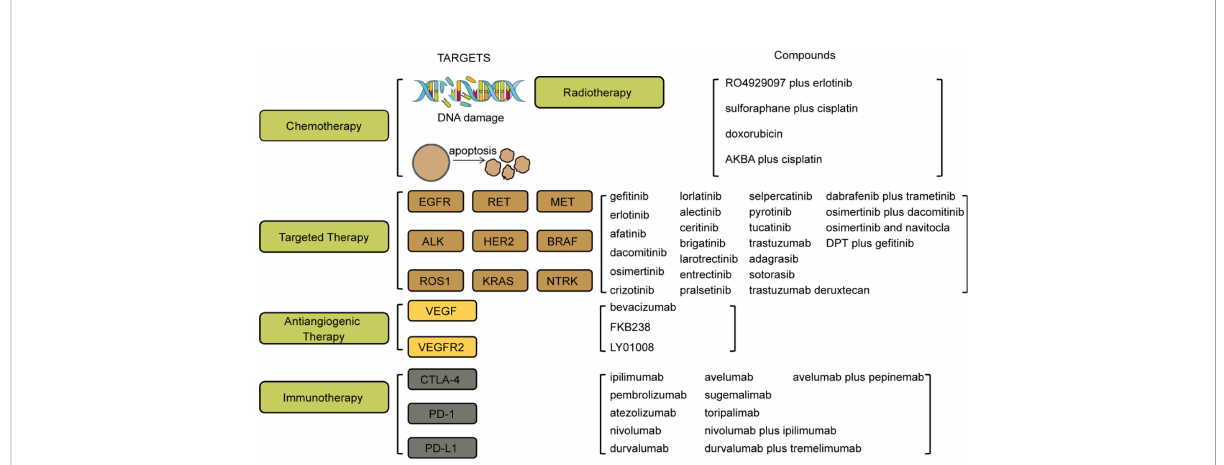
FIGURE 3 Targets and compounds in the treatment of NSCLC. Therapies in use are chemotherapy, targeted therapy, antiangiogenic therapy, and immunotherapy. Targets in chemotherapy include DNA damage and apoptosis. Targets in targeted therapy are EGFR, RET, MET, ALK, HER2, BRAF, ROS1, KRAS, and NTRK. Targets in antiangiogenic therapy are VEGF and VEGFR2. Targets in immunotherapy are CTLA-4, PD-1, and PD- L1. The corresponding drugs or compounds are listed on the